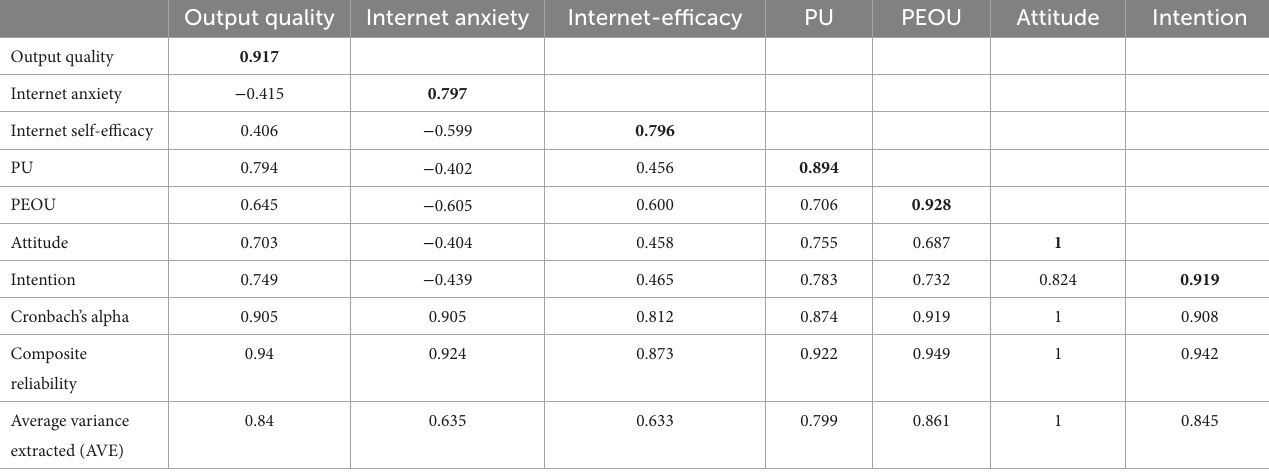
TABLE 3 Discriminant analysis and convergent validity.